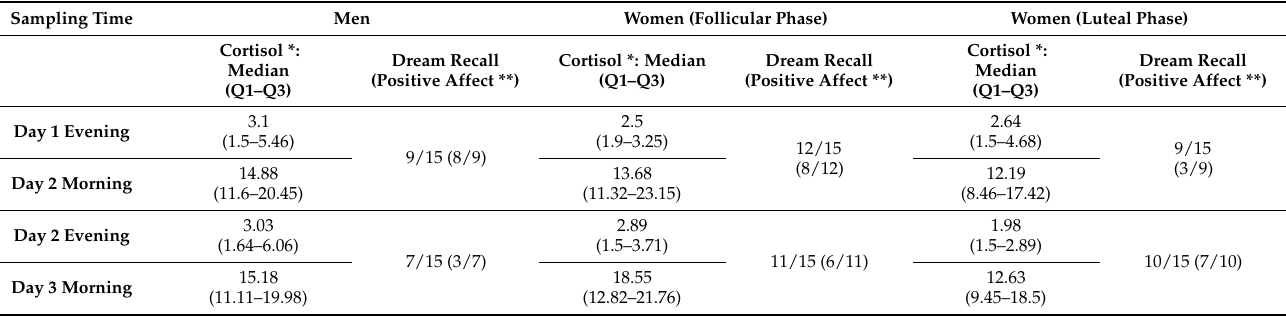
Table 1. Cortisol levels and dream